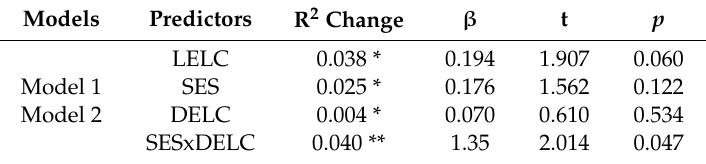
Table 11. Results of the hierarchical regression analyses on theory of mind (ToM). R 2 =